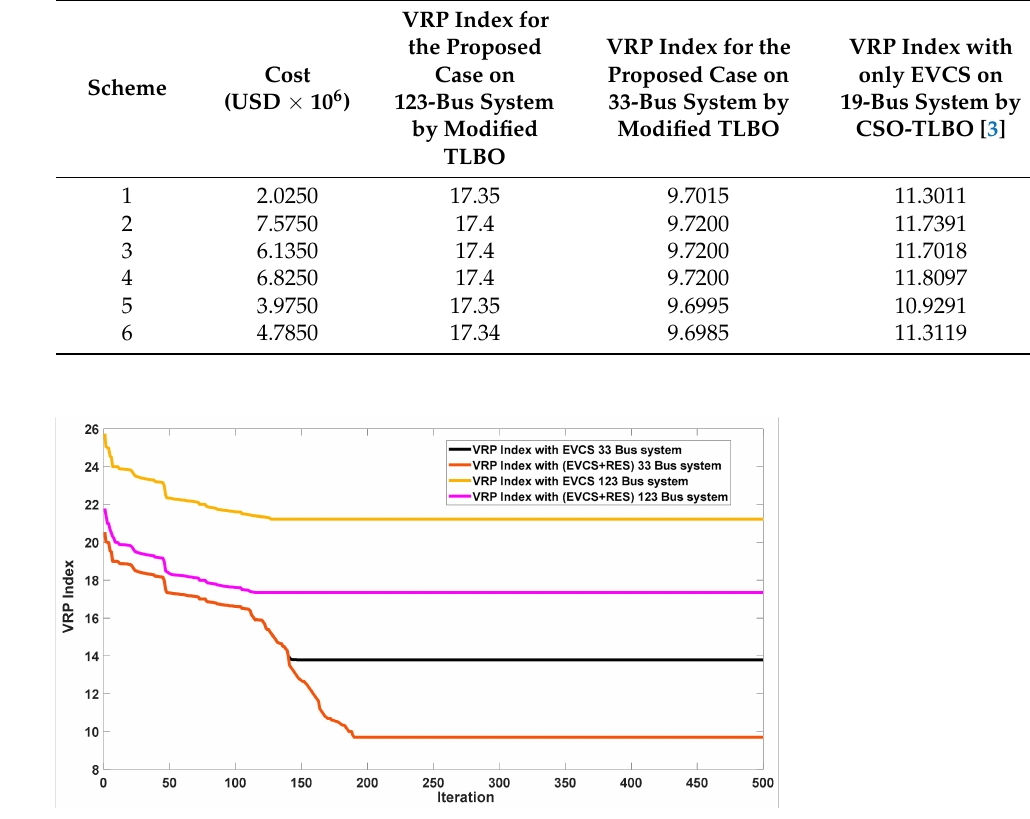
Figure 21. Optimal pareto solution for 123-bus system. 6. Conclusions The rapid increase in EVCS loads can cause voltage unsteadiness and reliability prob- lems. Due to the large-scale penetration of RESs, the reliable operation of the distribution network may be affected, which can strain the grid network ’ s performance. To address this particular issue, a new operation strategy is employed. This paper gives insight into the optimum sizing and location of EVCSs and RESs in a DC MG integrated with a utility grid. The present work is solved in a multi-objective context including cost and distribu- tion network operational aspects such as voltage stability, power loss, and reliability. The major focus is to decrease the VRP index of the distribution unit under six diverse schemes of operation. For the proposed case, the minimum value of cost obtained is USD 2.0250 × 10 6 . The CSs are optimally placed at bus numbers 2, 19, and 20 and 16, 43, and 107 on 33 and 123 test systems, respectively. The RESs are optimally placed at 2, 18, and 30 and 60, 72, and 102 on 33 and 123 test units, respectively. The power loss on a medium scale and large scale is reduced by 14.59%, 9.714% and 6.09%, 4.44%, respectively, for the proposed case concerning EVCS placement alone and regarding the base case. An efficient meta- heuristic-modified TLBO technique is applied in MATLAB to solve this complex problem.